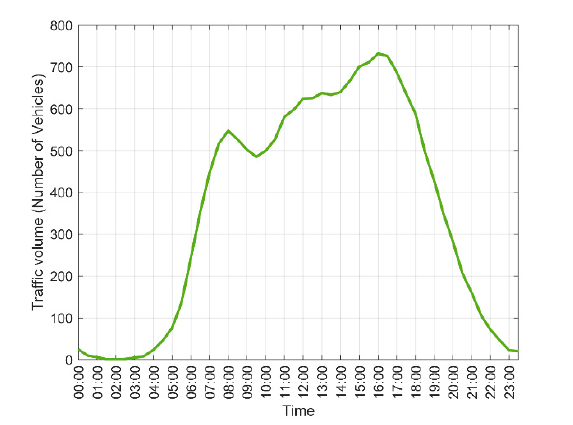
Figure 2. Number of vehicles in driving mode throughout the